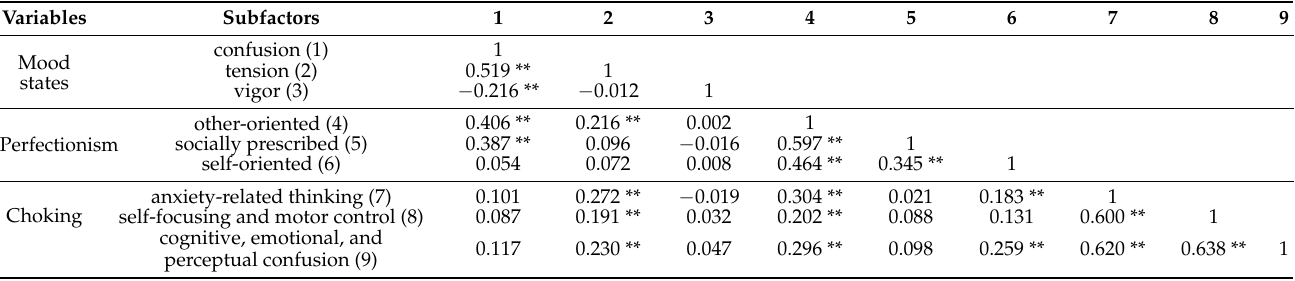
Table 4. Pearson’s correlations among mood states, perfectionism, and choking.